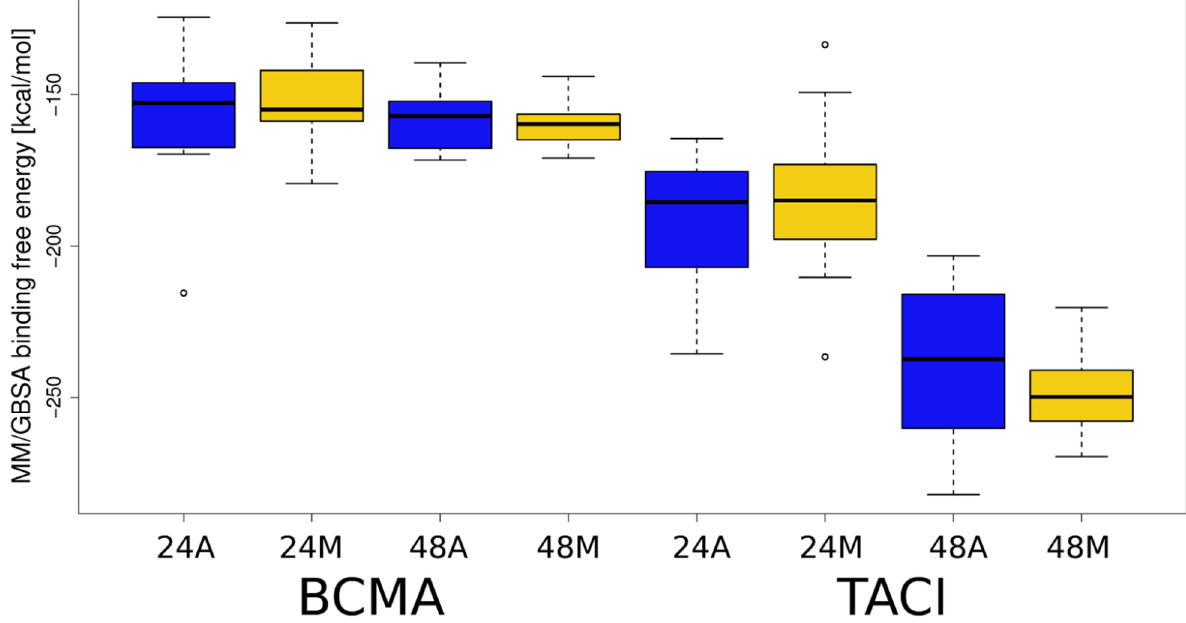
Figure 5. MM/GBSA binding free energies obtained for APRIL–BCMA/TACI–HP systems. Boxplot representation for the values provided in Table S2 is plotted: X-axis, BCMA and TACI correspond to the APRIL complexes with BCMA and TACI, respectively; 24 and 48 correspond to HP dp24 and HP dp48, respectively; A and M correspond to the automatically and manually selected structures, respectively.